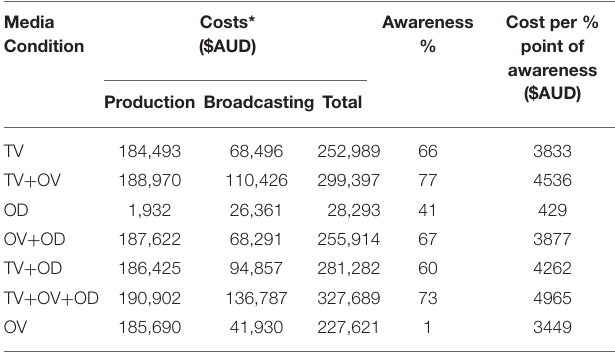
TABLE 1 | Media costs by